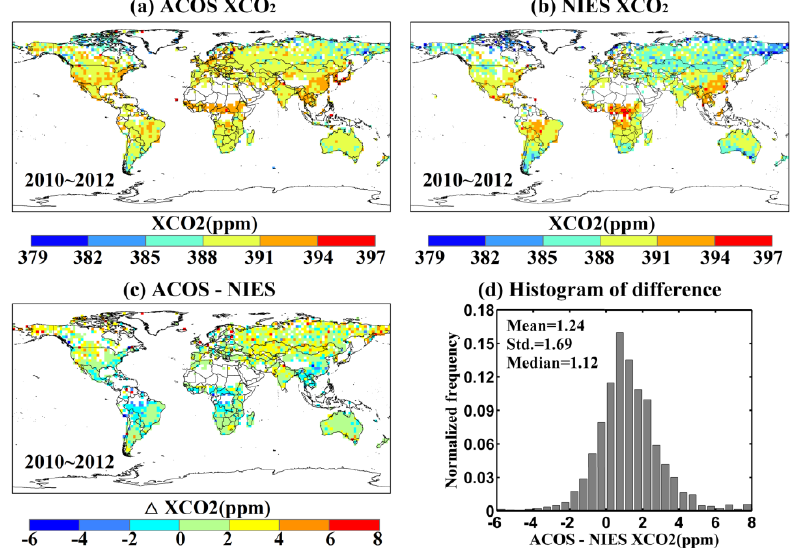
Figure 4. Global distribution of three-year averages of ACOS ( a ) and NIES ( b ) XCO 2 and their difference ( c ) gridded in 2.5° × 2.5° bins from 2010 to 2012; the histogram of difference shown in ( c ) is presented in ( d ).